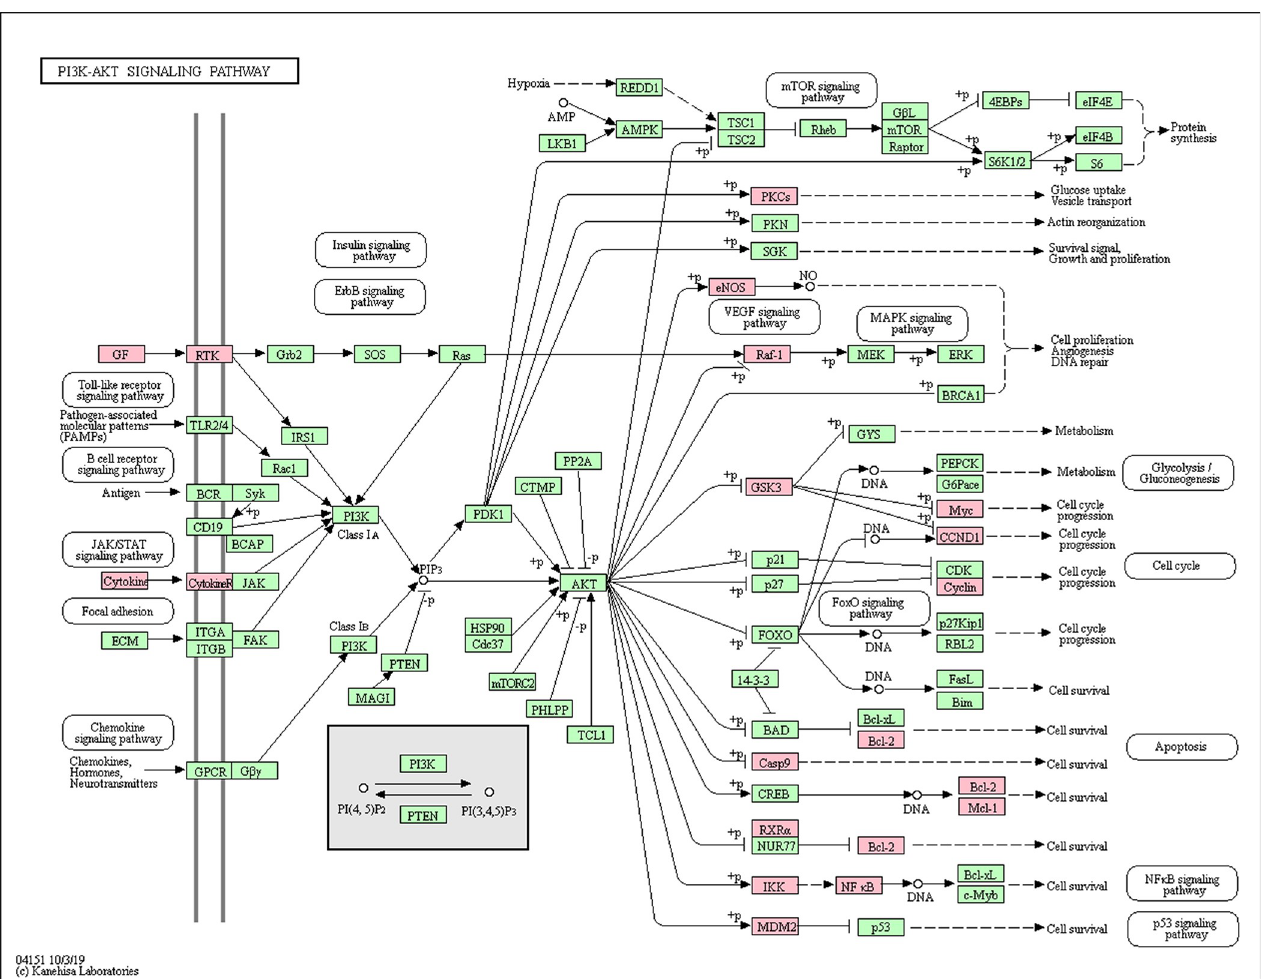
Fig 8. PI3K-AKT signaling pathway. The red rectangle represents the targets related to the core component-target-pathway network.